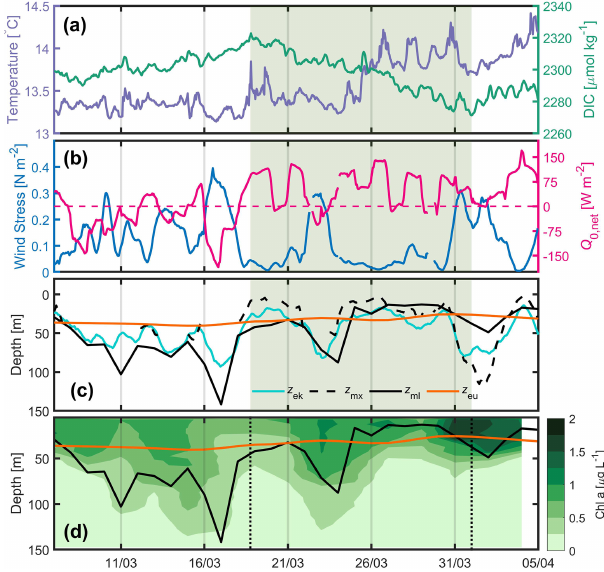
Figure 2. 2016. (a) Hourly DIC (green) and SST (sea surface tem- perature; purple) at the BOUSSOLE site, (b) hourly wind stress (blue) and net heat flux (pink) at the Azur buoy site. The pink dotted line indicates the change in sign of the net heat flux from negative to positive values, (c) daily depths of the mixed layer (black), mixing layer (dotted black), Ekman layer (cyan) and eu- photic layer (orange) at the BOUSSOLE site. The black dotted line in panels (a) , (b) , (c) and (d) indicates the beginning of DIC de- crease on 18 March. (d) Glider-derived depths of the mixed layer (black curve, same as in c ), euphotic layer (orange) and nighttime 2d binned chlorophyll concentration (green colouring) retrieved be- tween 7 March and 5